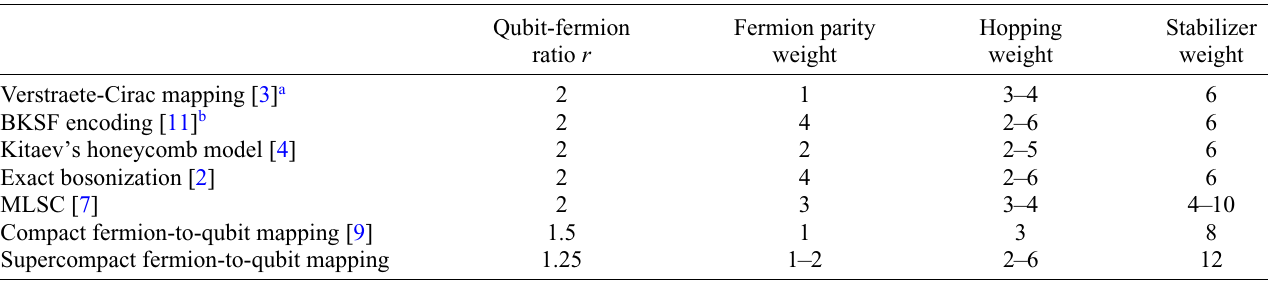
TABLE I. Comparison between fermion-to-qubit mappings on the 2d square